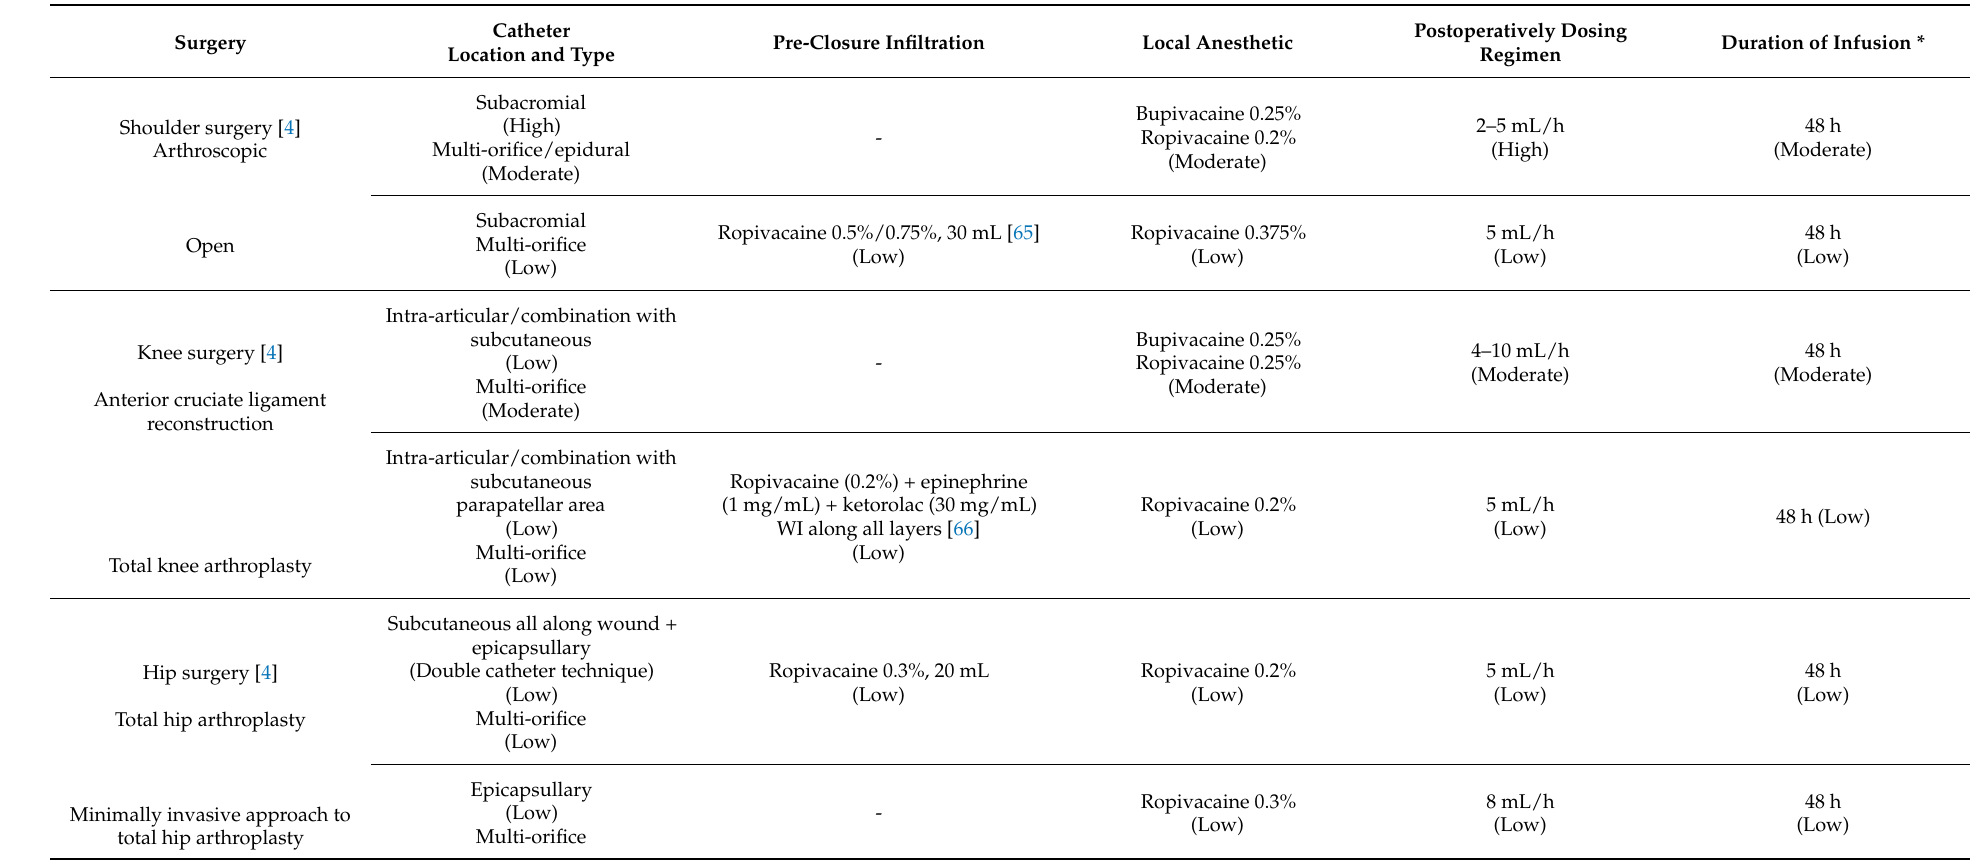
Table 2. Summary of recommended local anesthetics doses by type of surgery where continuous wound infiltration is